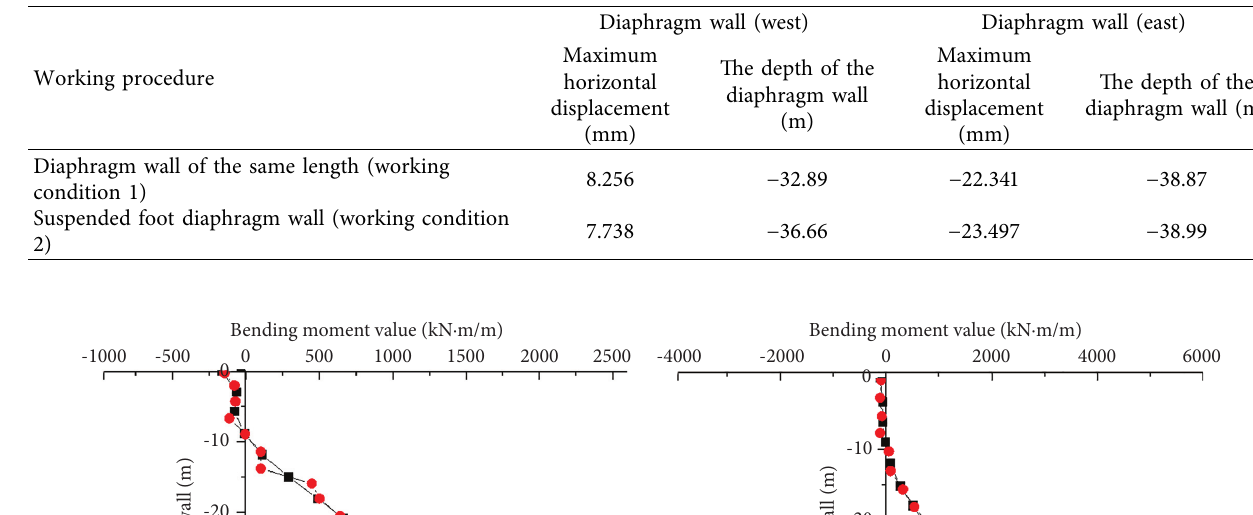
Figure 18: The horizontal displacement curve of the diaphragm wall. (a) West wall. (b) East wall. Table 10: The corresponding depth of maximum horizontal displacement of diaphragm wall during the 10th excavation step under two working conditions.